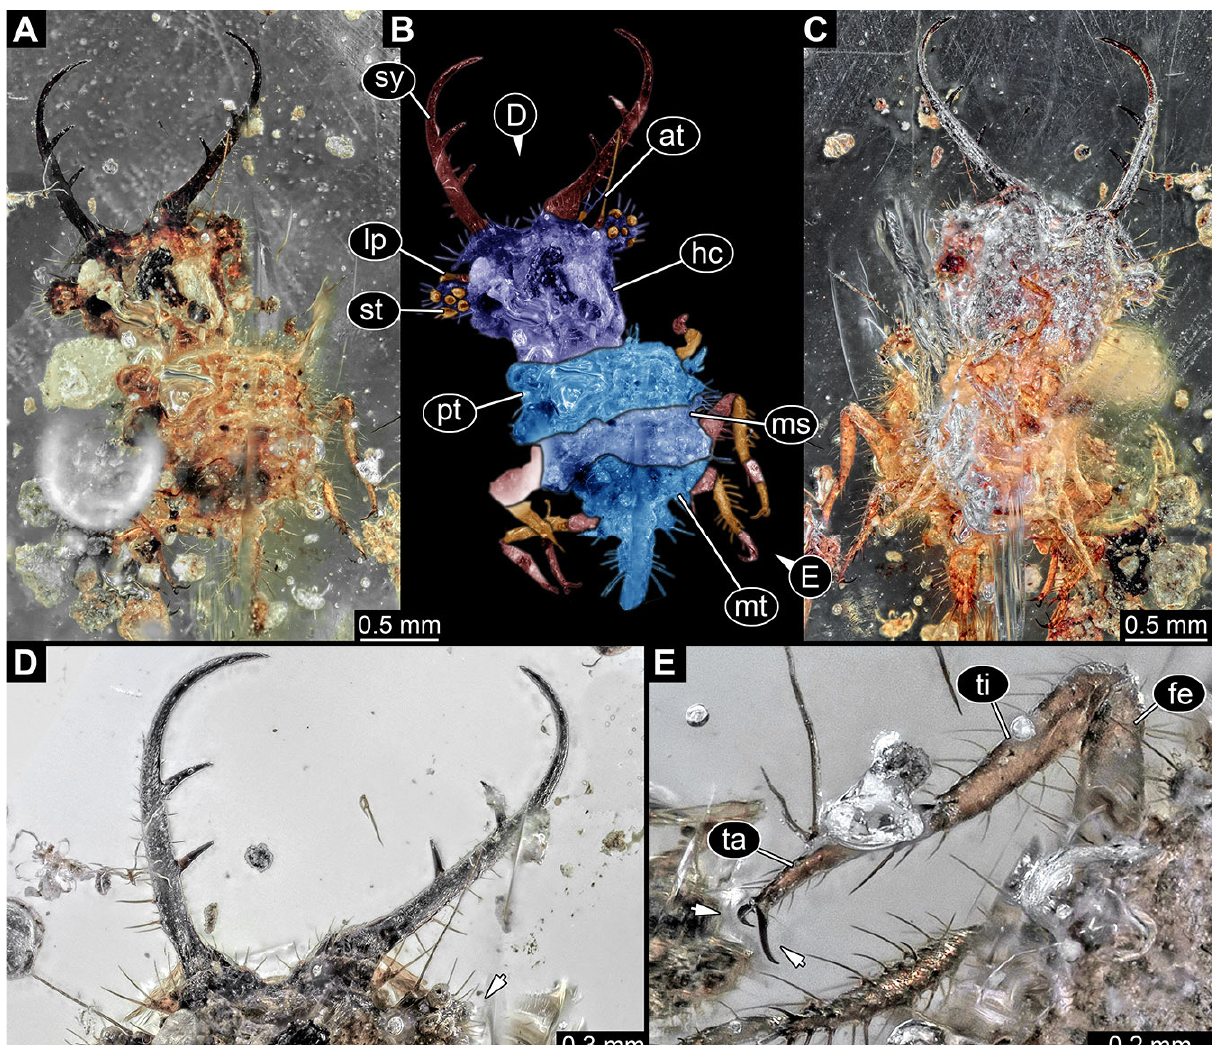
Figure 24. Fossil owllion larva, specimen 3237 (PED 0319), Cretaceous Kachin amber, Myanmar. ( A ) Overview, dorsal. ( B ) Color-marked version of ( A ). ( C ) Overview, ventral. ( D ) Close-up on head capsule with field of stemmata (arrow). ( E ) Close-up on locomotory appendage with claws (arrows). Abbreviations: at = antenna; fe = femur; hc = head capsule; lp = labial palp; ms = mesothorax; mt = metathorax; pt = prothorax; st = stemmata; sy = stylet; ta = tarsus; ti = tibia. 27. Specimen 3238 (PED 0320), preserved in Cretaceous Kachin amber, Myanmar. Spec-